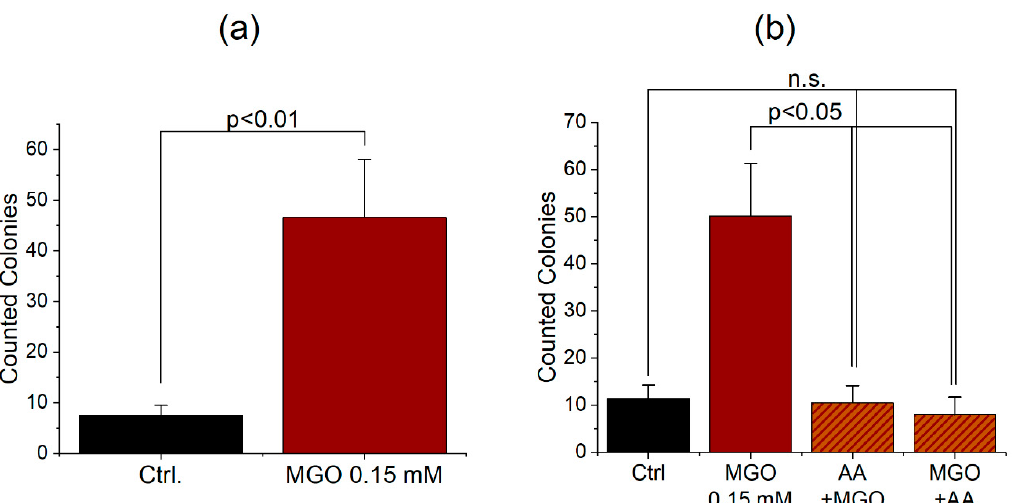
Figure 3. Increased microbial traversal through a BBB model upon treatment with MGO ( a ). THBMECs were treated with 0.15 mM MGO for 1 h. 450 µ L of bacteria suspension (OD 0.5) were put into each upper chamber. Medium from the lower chamber was plated on agar plates after 6 h. Graphs show the mean + SEM of counted colonies, untreated cells serve as control, ( n = 3). Microbial traversal in the presence of ascorbic acid decreased in MGO-treated cells ( b ). THBMECs were treated with 0.15 mM MGO for 1 h. Afterwards, ascorbic acid with a concentration of 0.1 mM was administered to the treated cells. Additionally, cells were first treated with ascorbic acid for 4 h and afterwards glycated with MGO 0.15 mM for 1 h. 450 µ L of E. coli suspension (OD 0.5) was put into each upper chamber. Medium from the lower chamber was plated on agar plates after 6 h. Graphs show the mean + SEM of counted colonies, untreated cells served as control, ( n = 3).